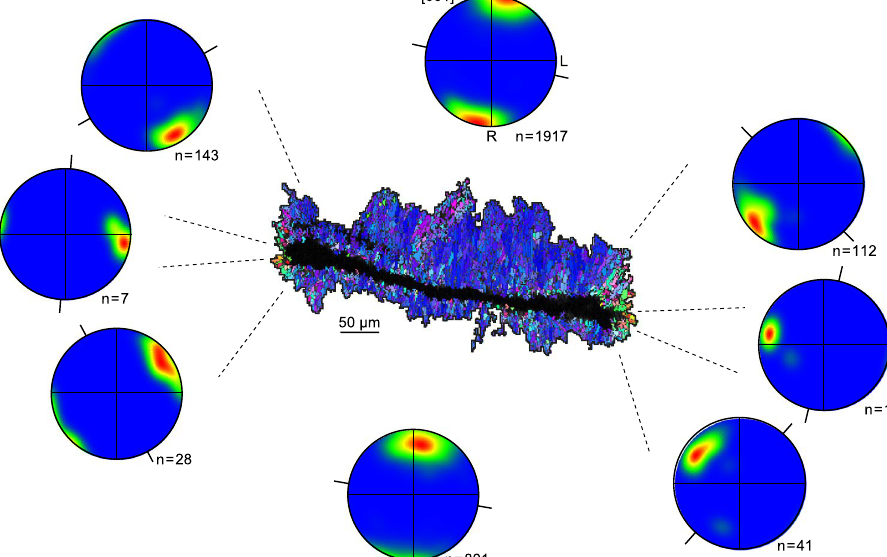
Figure 6. Aragonite growth normal to calcification interface. Inverse pole figure (IPF) map of the crystallization lamella highlighted in Fig. 2, along with aragonite [001] pole figures corresponding to the sectors delimited by dashed lines. Projection and contouring parameters as in Figs 4 and 5, except that the Gaussian half-width has been set to 20° to avoid non-representative peaks in sectors with poor statistics (i.e. small n). The orientation of the calcification interface is indicated by black lines. R and L are shown only for the pole figure at the top centre. IPF map colour code as in Fig. 2.